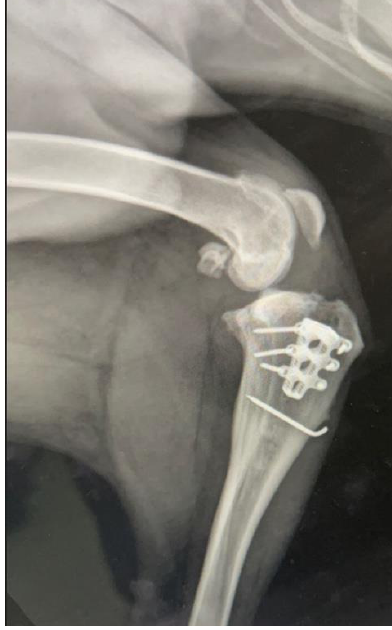
Figure 3. Complete bone healing 3 months postoperative.